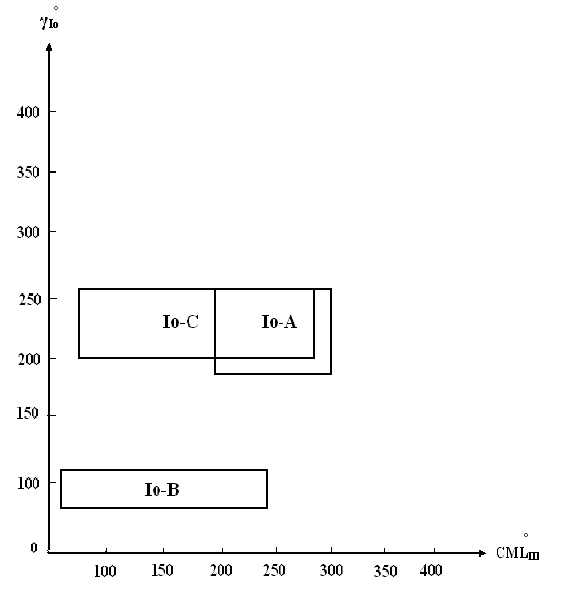
Fig.16: The theoretical